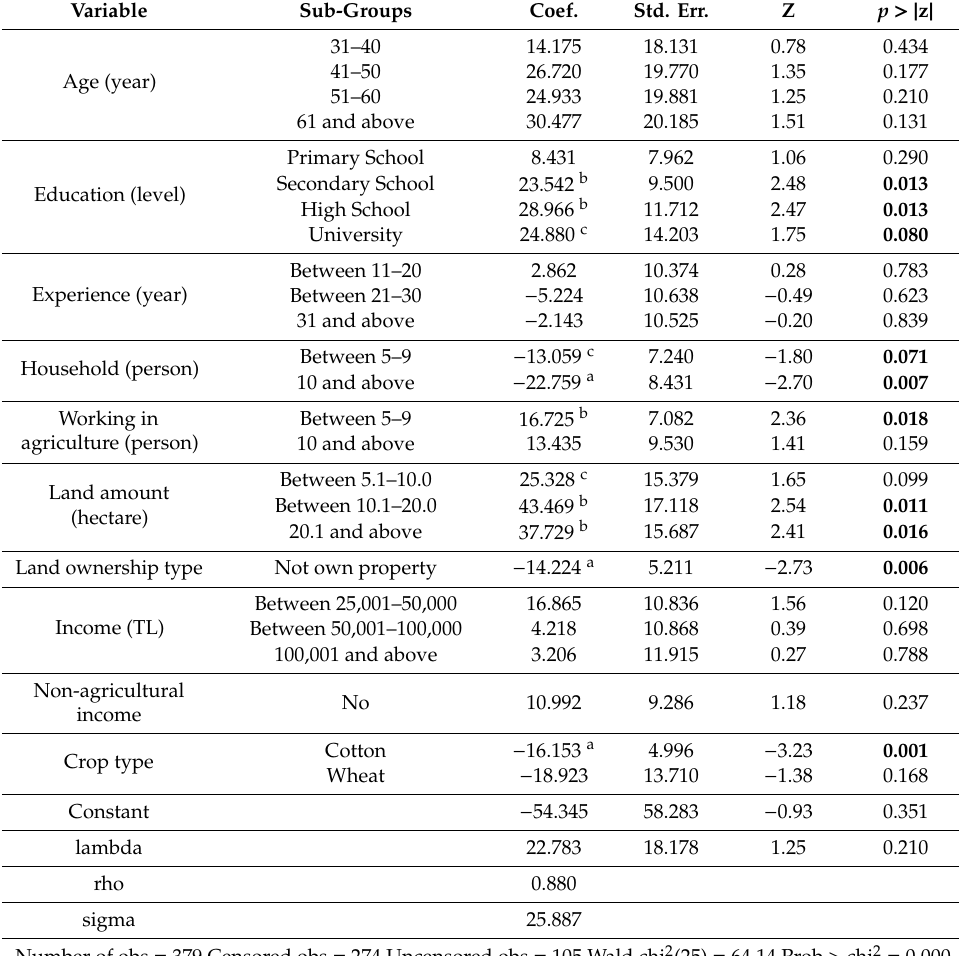
Table 4. Heckman’s second-stage model (OLS model / payment model) estimation results.